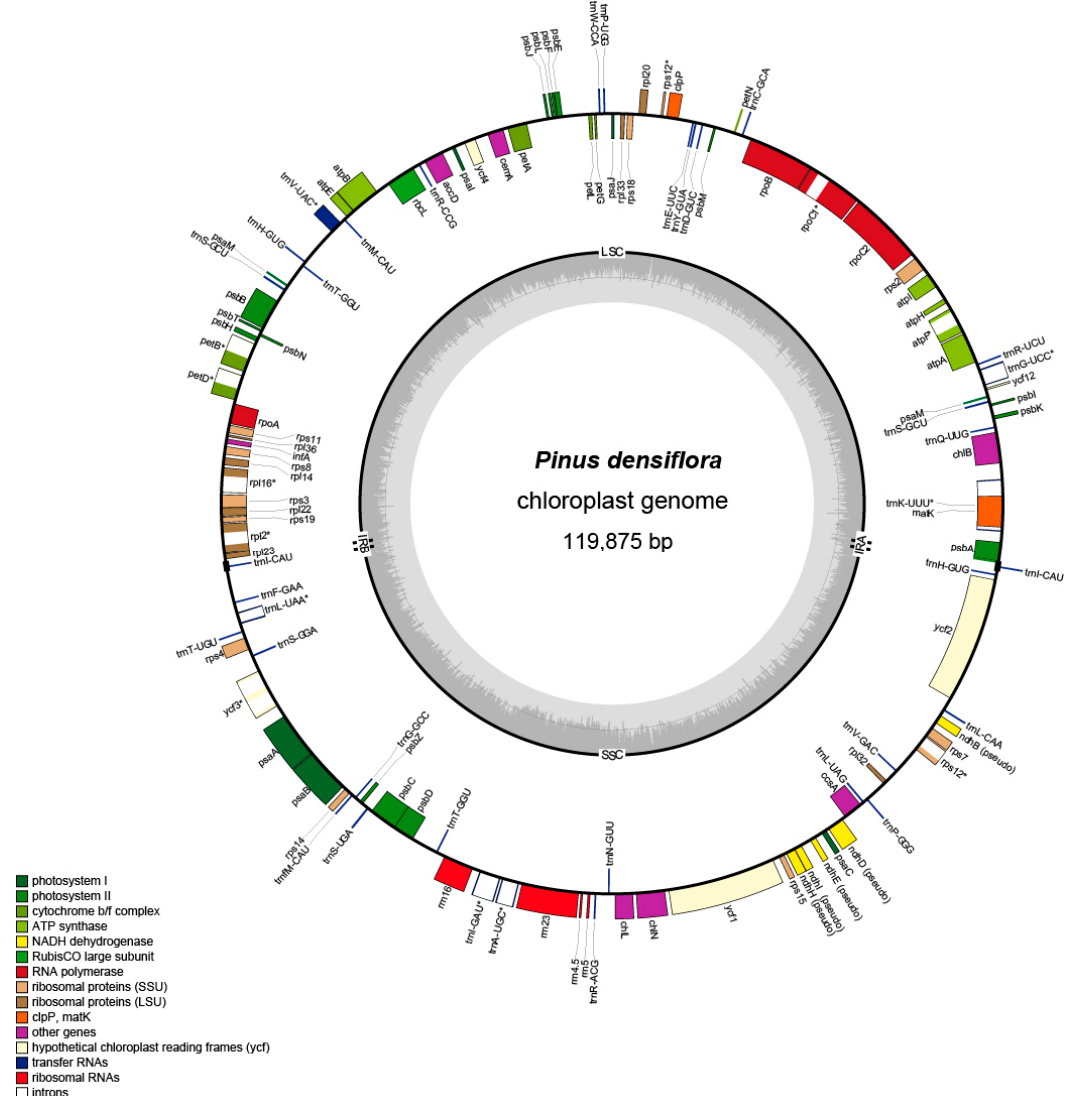
Figure 1. Gene map of the P. densiflora chloroplast genome. Genes drawn inside the circle are transcribed clockwise, while those drawn outside are transcribed counterclockwise. Different functional gene groups are color-coded. A GC-content graph is depicted within the inner circle. The circle inside the GC content graph marks the 50% threshold.